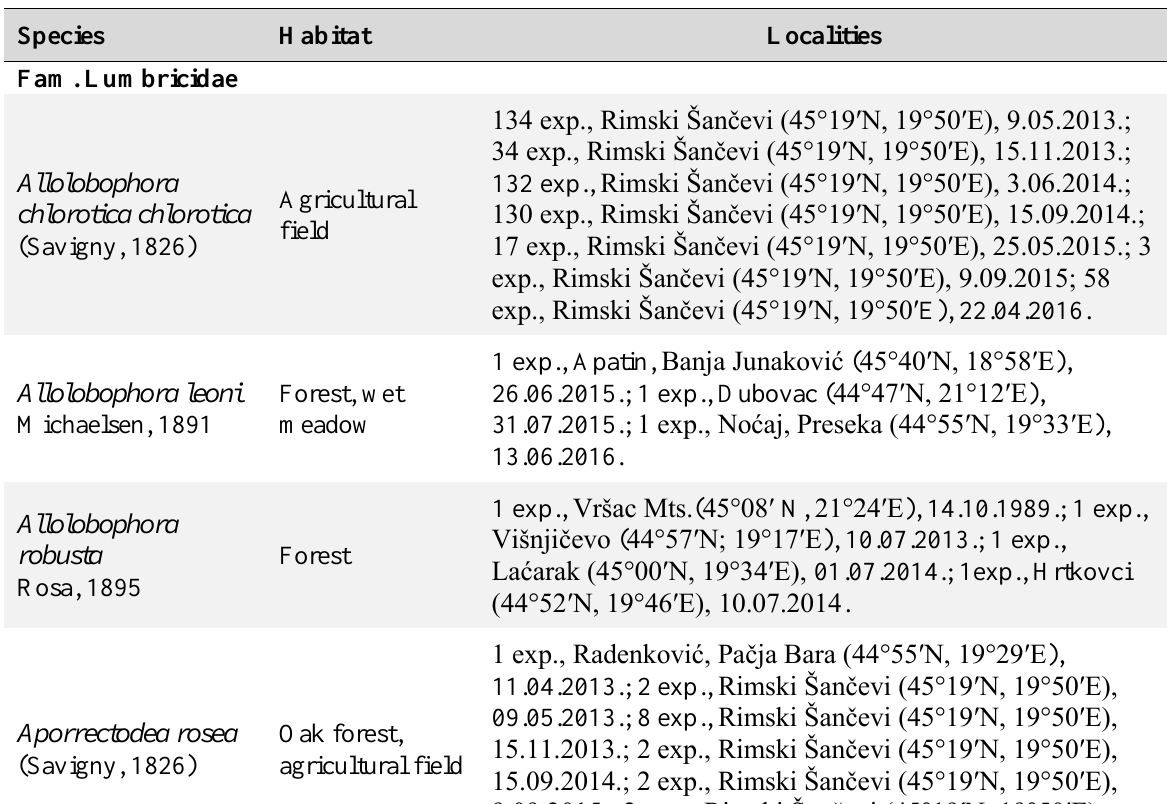
Table 1. List of the collected lumbricid taxa and their localities